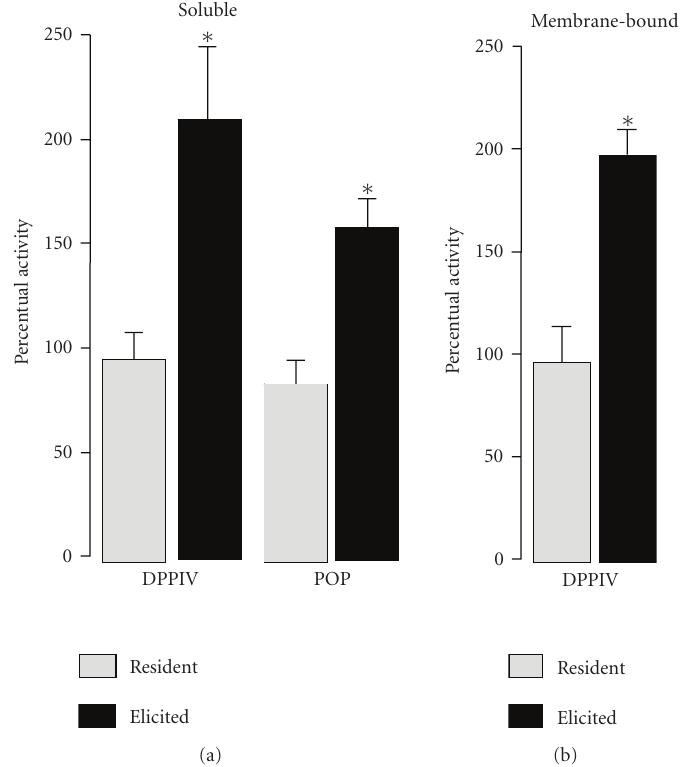
Figure 3: Percentual activity of soluble and membrane-bound dipeptidyl peptidase IV (DPPIV) and prolyl oligopeptidase (POP) activities in resident and thioglycollate-elicited murine macrophages from methotrexate-treated in relation to their respective controls (100%). Values are means ± SEM from 5 animals (assays made in triplicate). ∗ P < . 001 in comparison to control (unpaired two-sided Student’s t